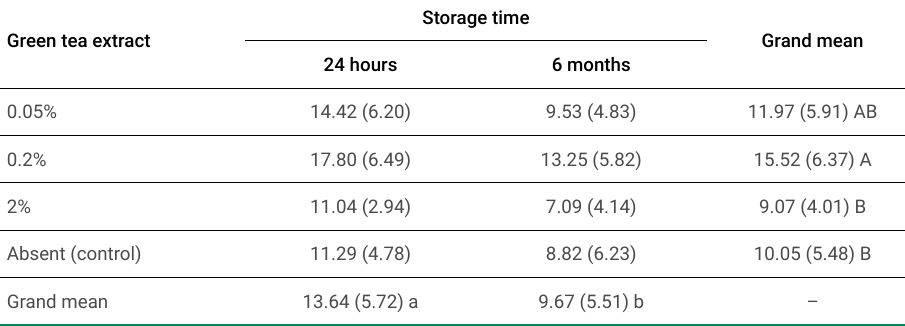
Table 2. Average values and standard deviation of the bond strength (in MPa), according to the concentration of the green tea extract solution applied to the dentin and the storage time. Green tea